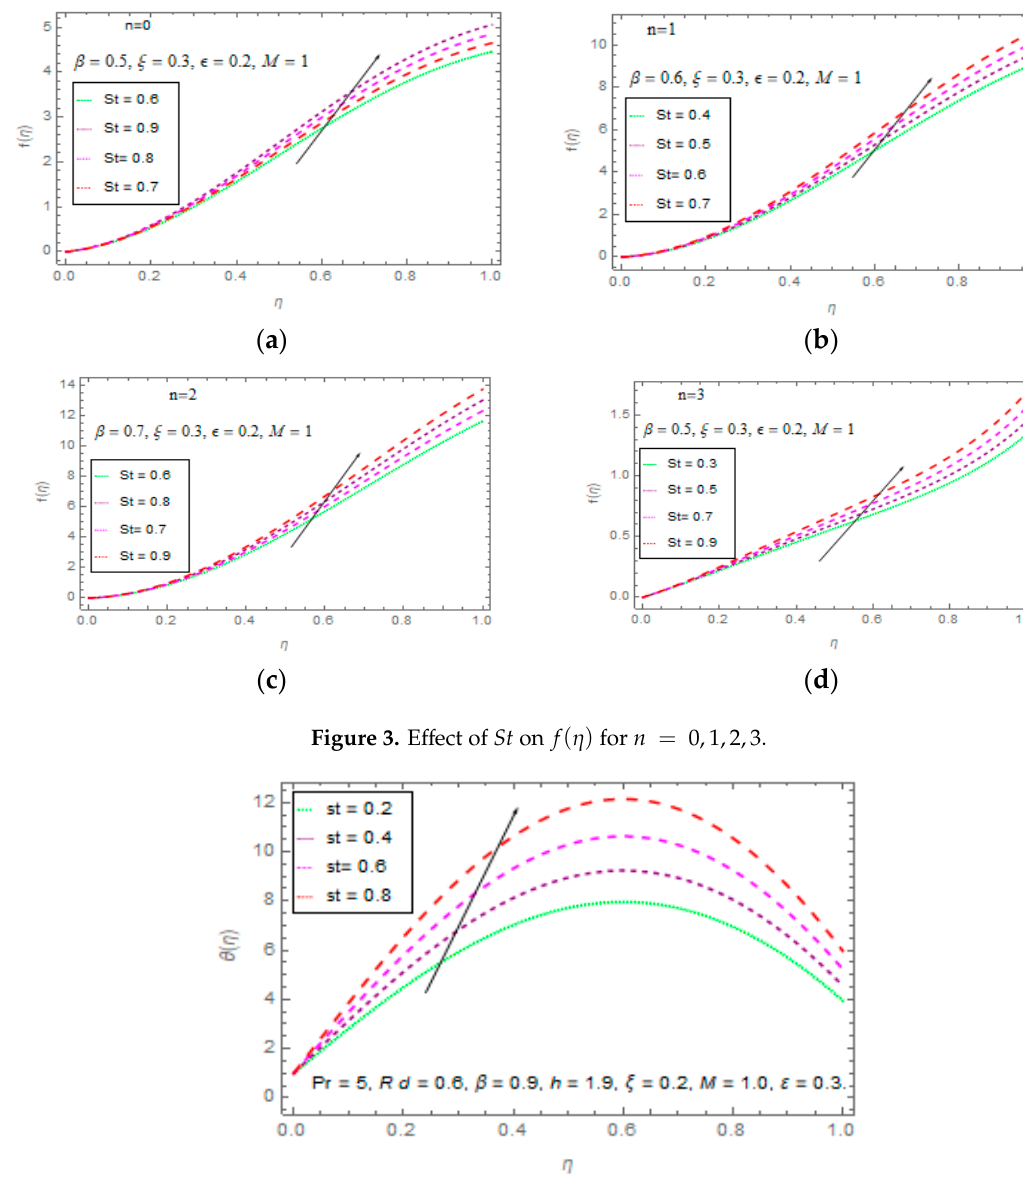
Figure 4. Effect of 𝑆𝑡 on 𝜃(𝜂) . Figure 4. E ff ect of St on θ ( η )